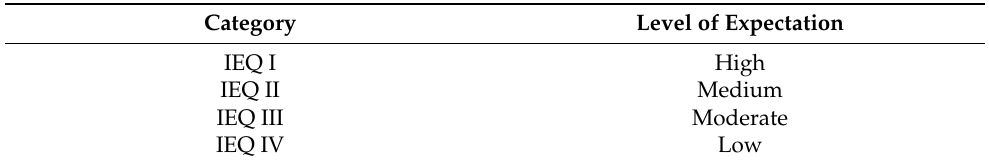
Table 6. Four categories of buildings according to the occupants’ level of thermal comfort expectations recommended by EN 16798-1 [40].